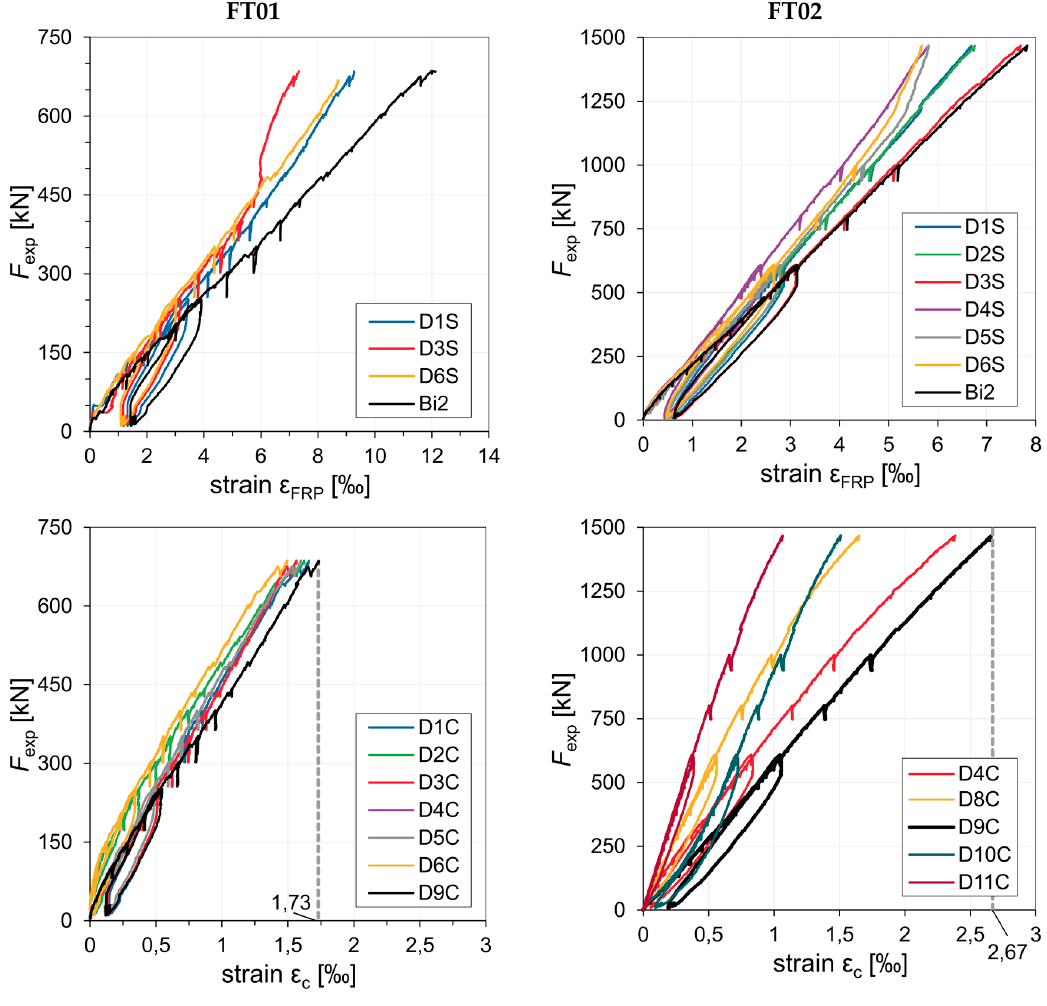
Figure 15. Strain measurements for FT01 ( left ) and FT02 ( right ) indicating that good prediction of Figure 15. S train measurements for FT01 (left) and FT02 (right) indicating that good prediction of strain distribution with spreadsheet calculation is possible. strain distribution with spreadsheet calculation is